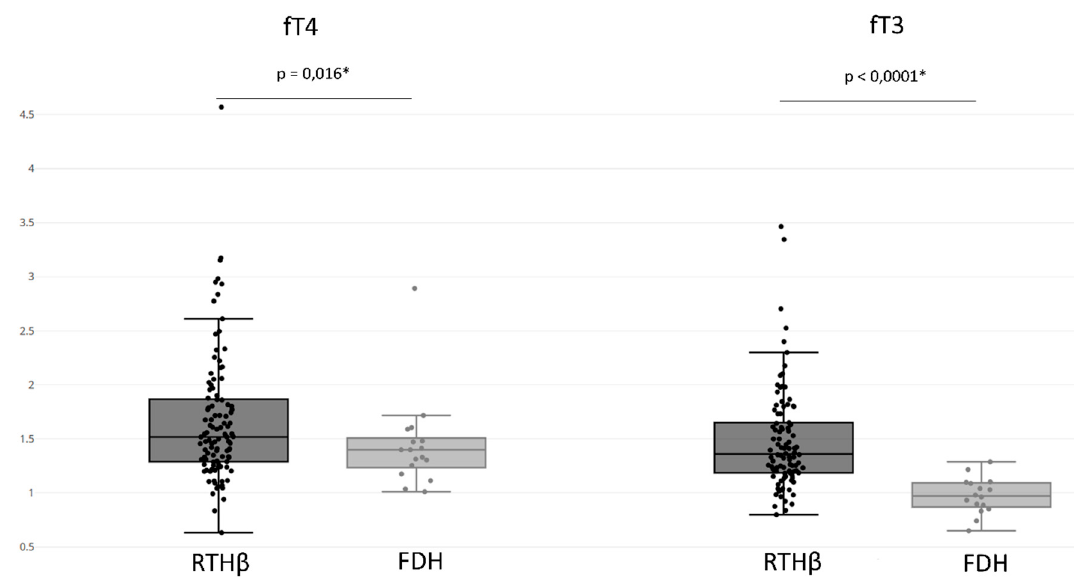
Figure 4. Thyroid function assays (free T4 (fT4) and free T3 (fT3) levels) in several patients with RTH β or FDH. fT4 and fT3 levels are expressed as multiples of the upper limit of the assay. The * symbol indicates a statistically significant p -value after correction for multiple statistical tests ( p < 0.05). Table 3. Percentage of index cases with variations of fT3 and fT4 according to the diagnosis of RTH β or FDH. fT4 (cid:37) fT3 (cid:37) fT4 (cid:37) fT3 Nl fT4 Nl fT3 (cid:37) RTH β 89% 8% 3% FDH 44% 56%